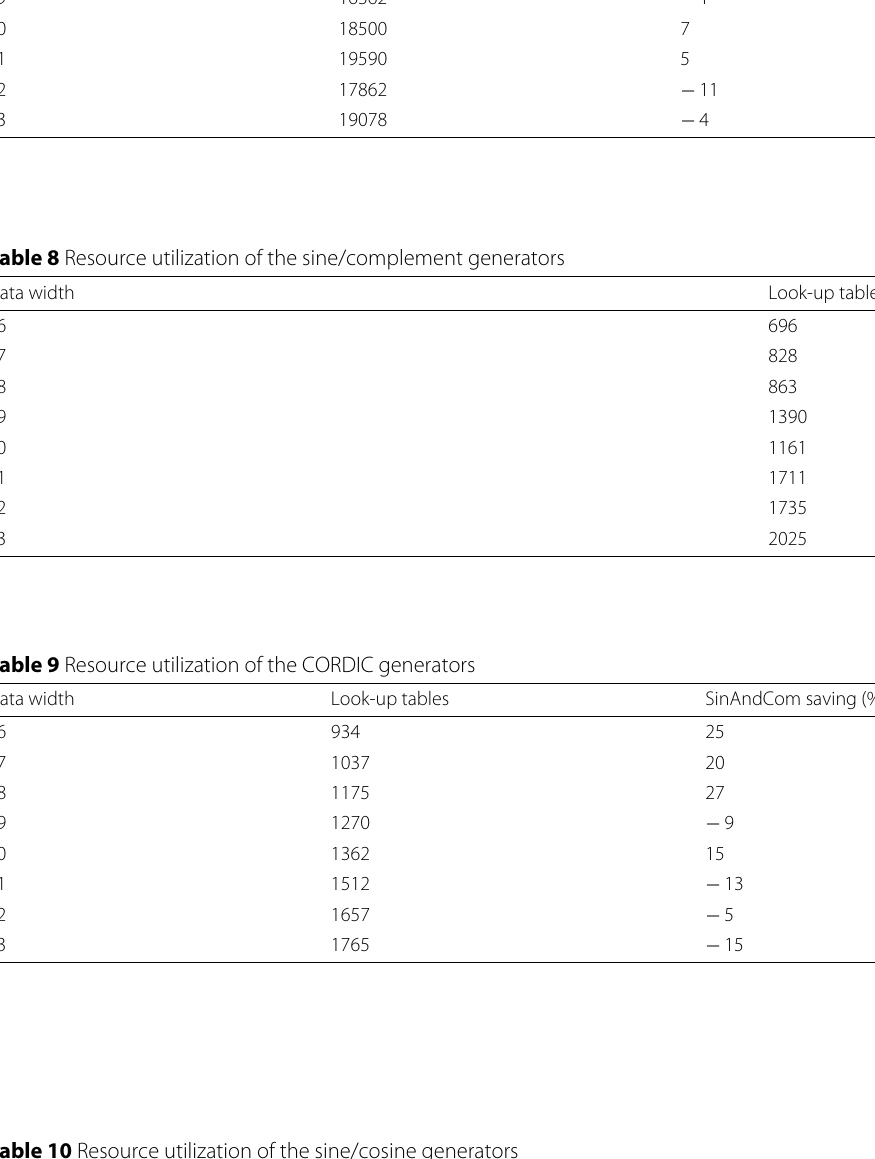
Table 10 Resource utilization of the sine/cosine generators Data